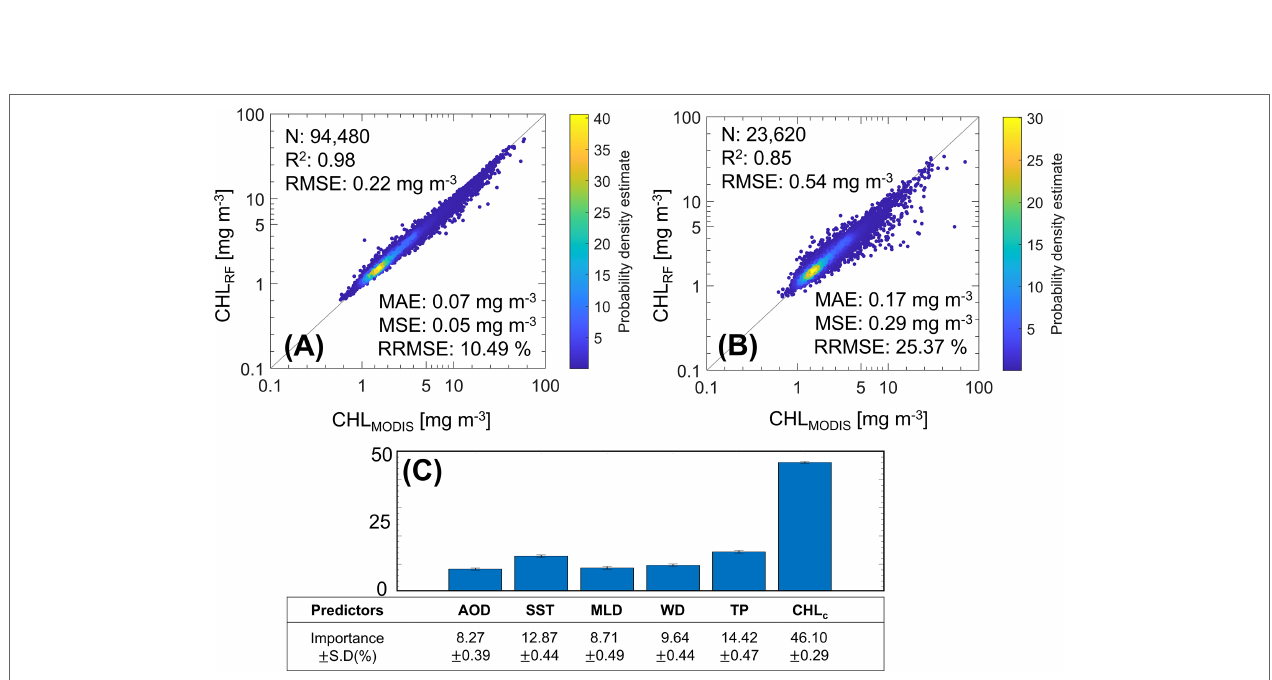
FIGURE 3 | Performance evaluation of RF model for the training set (A) and validation set (B) between MODIS-Aqua CHL ( CHL MODIS ) and the RF model-derived CHL ( CHL RF ) The evaluation of variable importance (VI) of each predictor is also included here (C)